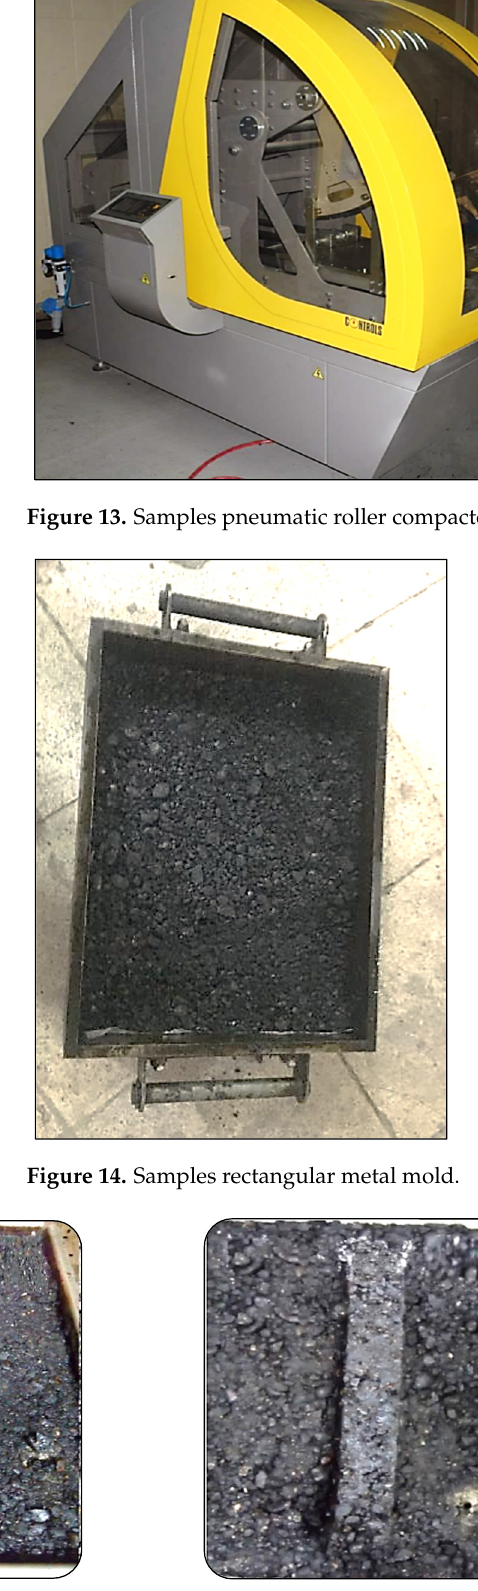
Figure 15. Asphalt slab samples.